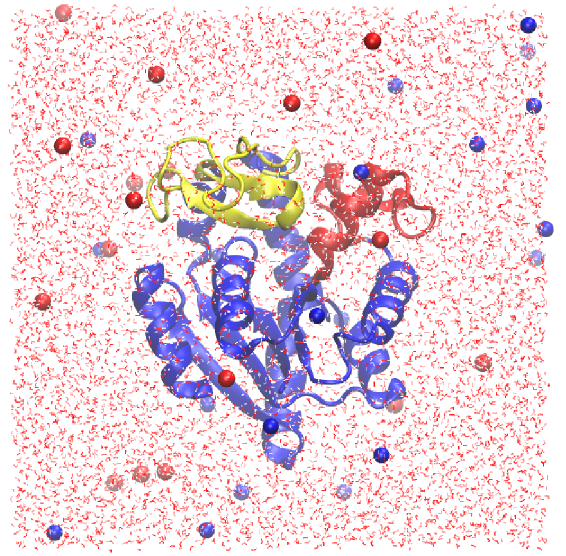
Figure 1. The simulation system. AdK was initially in the closed conformation in this particular simulation. The AMPbd, LID, and CORE domains of the protein are colored red, yellow, and blue, respectively. K + and Cl 2 ions are drawn as blue and red spheres, respectively. The image was rendered using the VMD software [45].